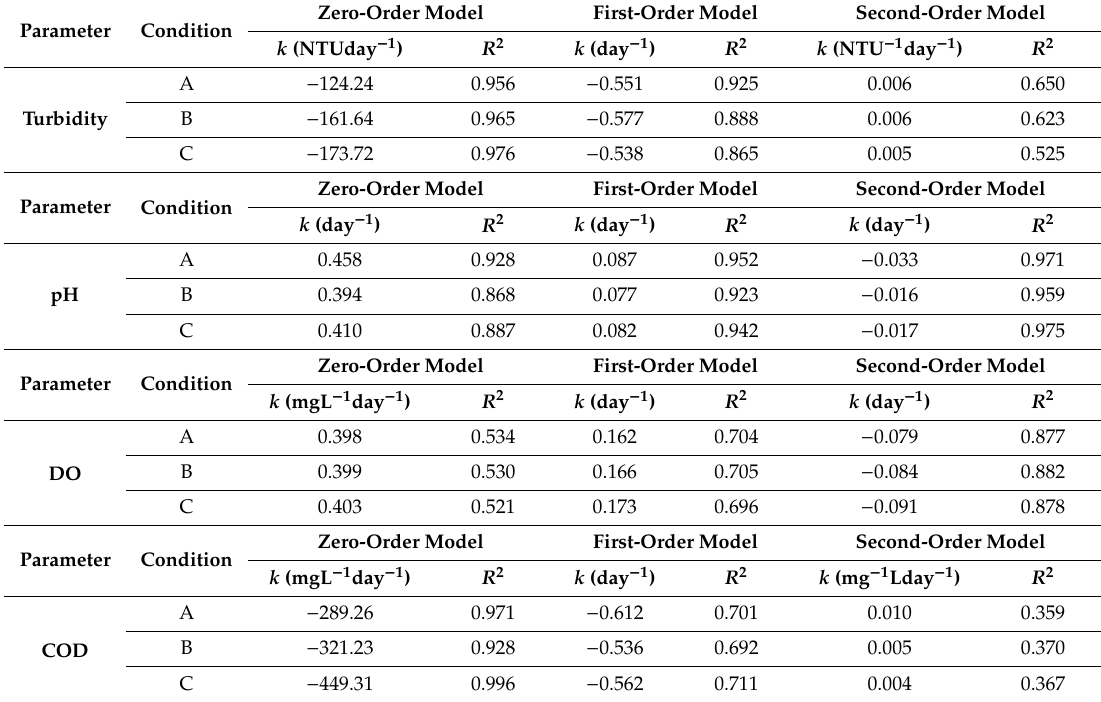
Table 5. Kinetics on quality changes of soaking water in condition A, B and